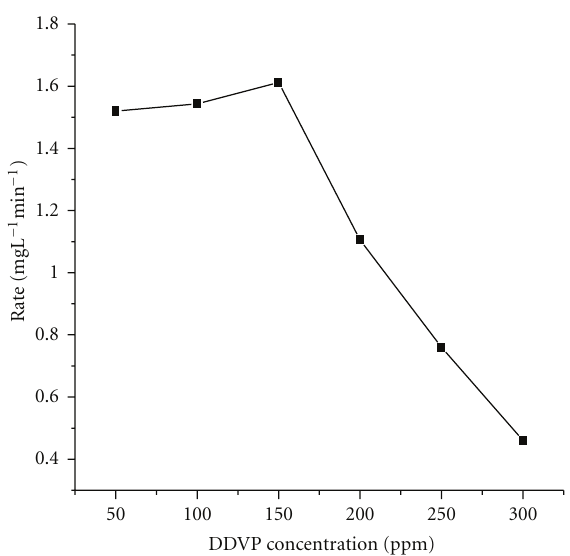
Figure 12: The e ff ect of concentration of DDVP on the degradation of dichlorvos by Mg 2+ -doped TiO 2 , pH = 2, catalyst dosage = 0.10 g.